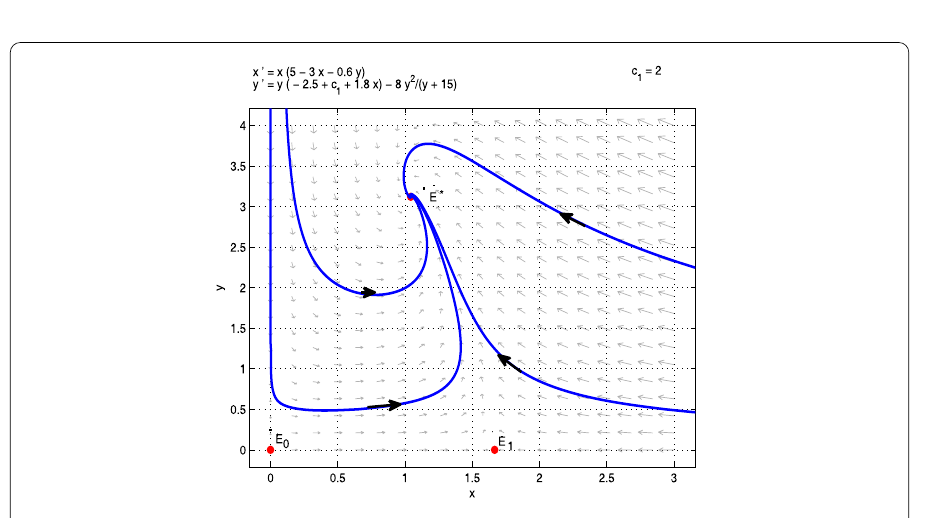
Figure 8 Dynamic behaviors of system (4.4) if c 1 =